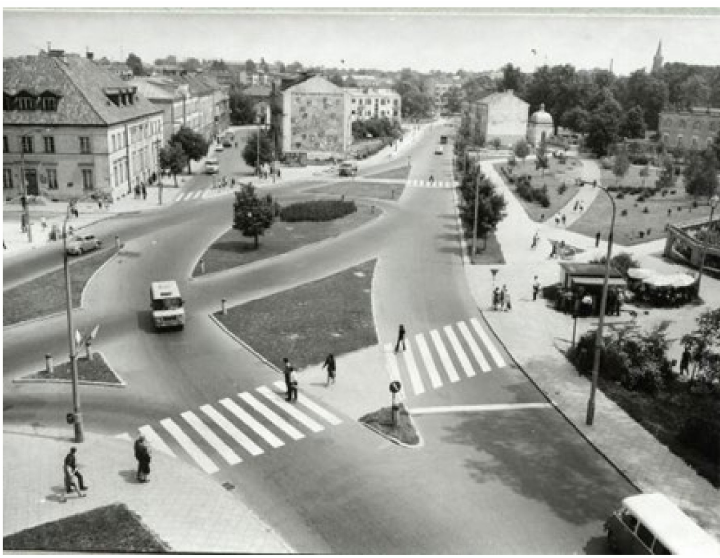
Figure 1. New streets realized near the Cathedral and the Palace in the 1960s of the 20th century (Archives of Urban Planning Department, Białystok Municipality).